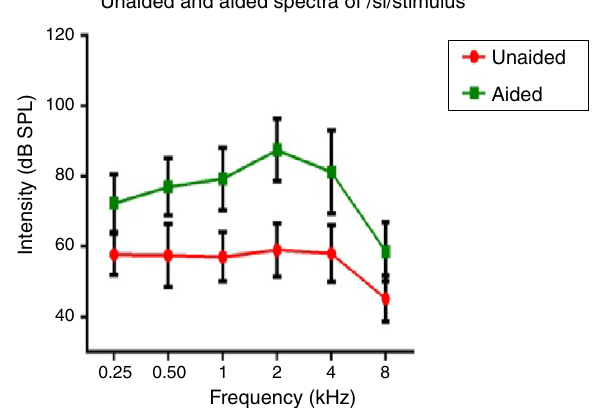
Mean and standard deviation of intensity of /si/ stimulus as a function of frequency in unaided and aided condi- tions.